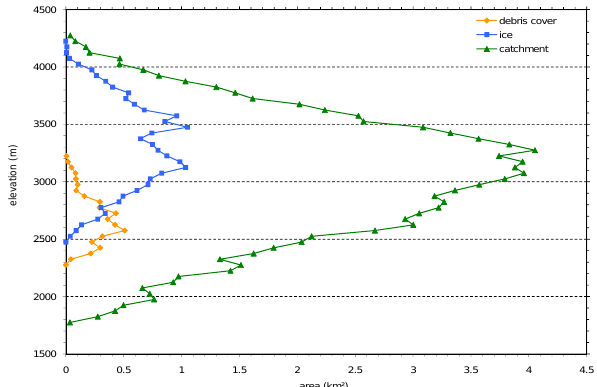
Fig. 6. Area elevation distribution for the six glaciers in the Adyl- su basin in 2000 based on Stokes et al. (2006) and the STRM 90m digital elevation model. The area distribution is divided into clean ice and debris covered